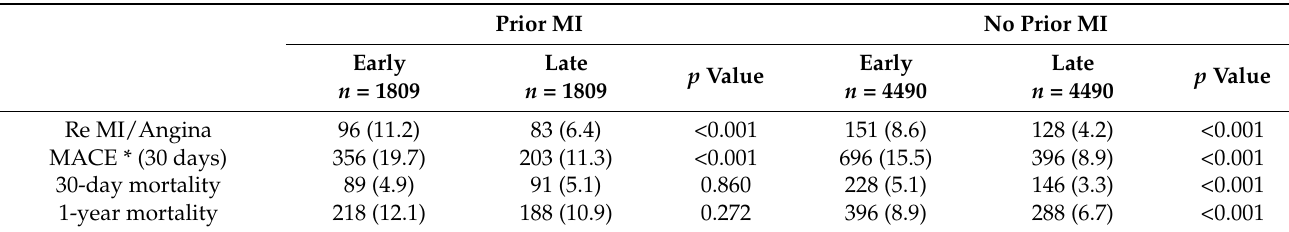
Table 3. Clinical outcomes of patients with and without prior MI compared between time periods (early 2000–2008 vs. late